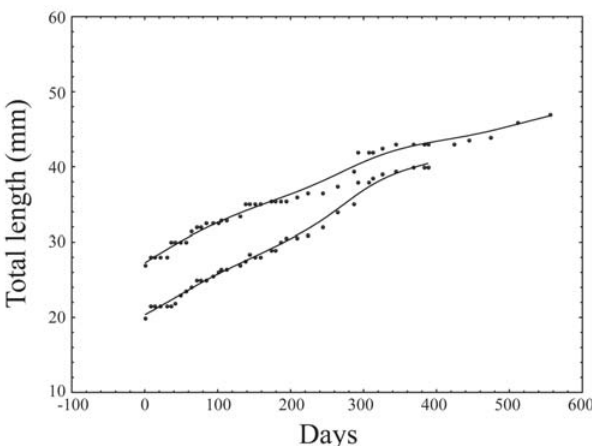
Fig. 5. Left eye size (diameter, in mm) versus total length (in mm) in the seven specimens (respectively a to g) of Ancistrus cryptophthalmus of the Passa Três 2004